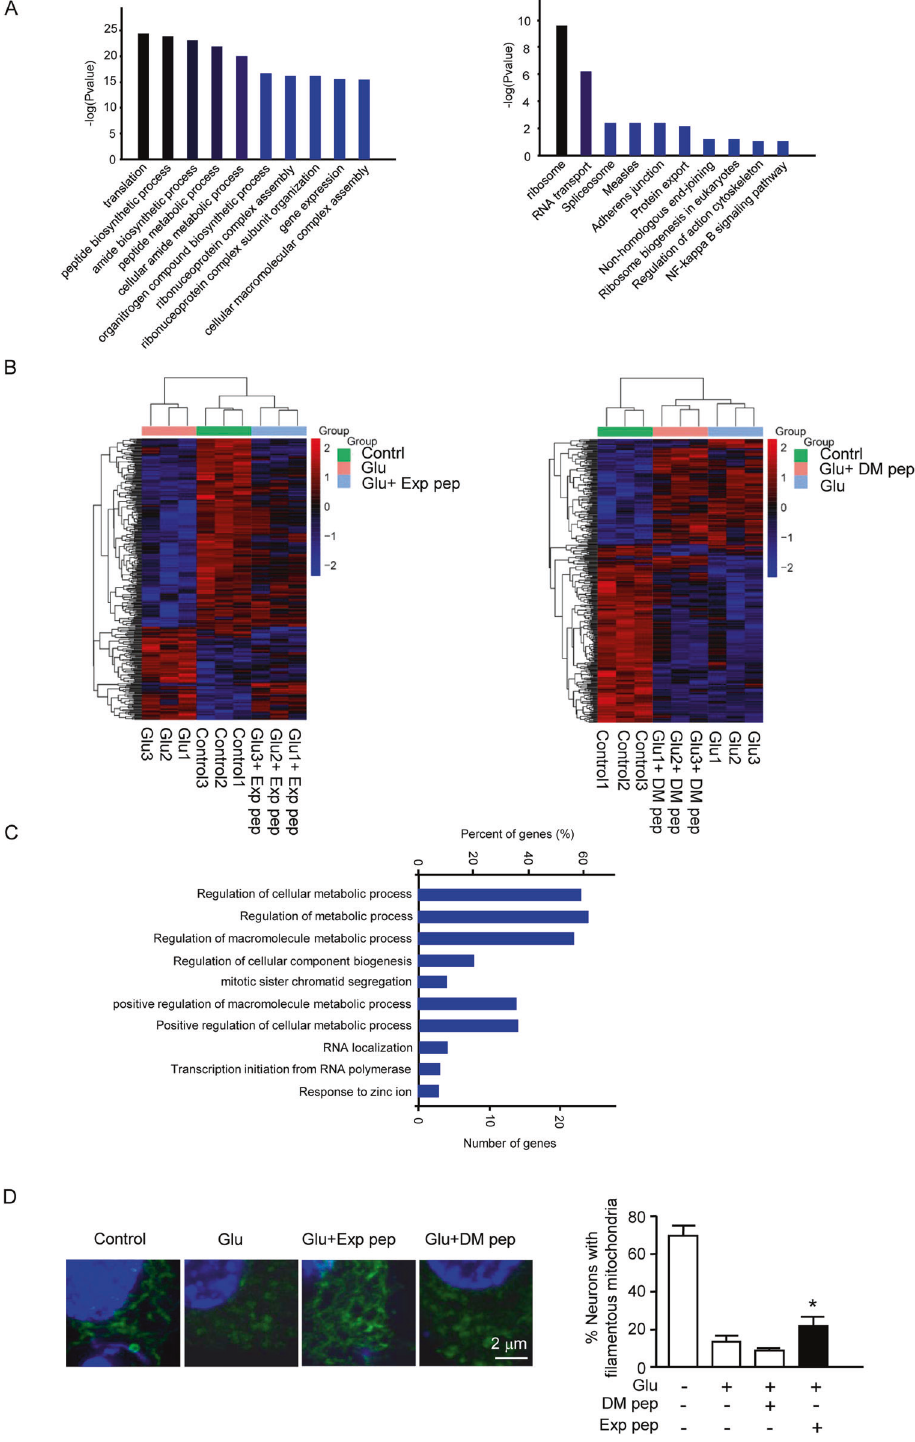
Fig. 5 The proteomic analysis to determine tRF and glutamate effect on metabolism. A One hour after transfection of the cytotoxic tRF, total proteins were collected and analyzed by proteomics. The results of GO and KEGG analysis were shown. Four independent samples were collected for each treatment. These samples were treated as a group to compare between groups. The enriched biological processes and pathways are indicated on the graph. B Three hours after glutamate treatment with or without Exp pep or DM pep pretreatment, total proteins were collected and analyzed by proteomics. Trial n = 3. The heat map showed reduced protein level after glutamate treatment, and Exp pep (but not DM pep) rescued the protein level reduction. C The result of the GO analysis was showed for the downregulated protein after glutamate treatment. D Mitochondrial fragmentation in neuronal necrosis. Forty minutes after glutamate treatment with or without pretreatment of Exp pep or DM pep, the primary neurons were fi xed and immune-stained with TOM20 to label mitochondria. The number of neurons displayed with fragmented mitochondria were determined. Trial n = 4. For each treatment, 15 randomly selected fi elds were examined for each trial. Cell Death and Disease (2021)